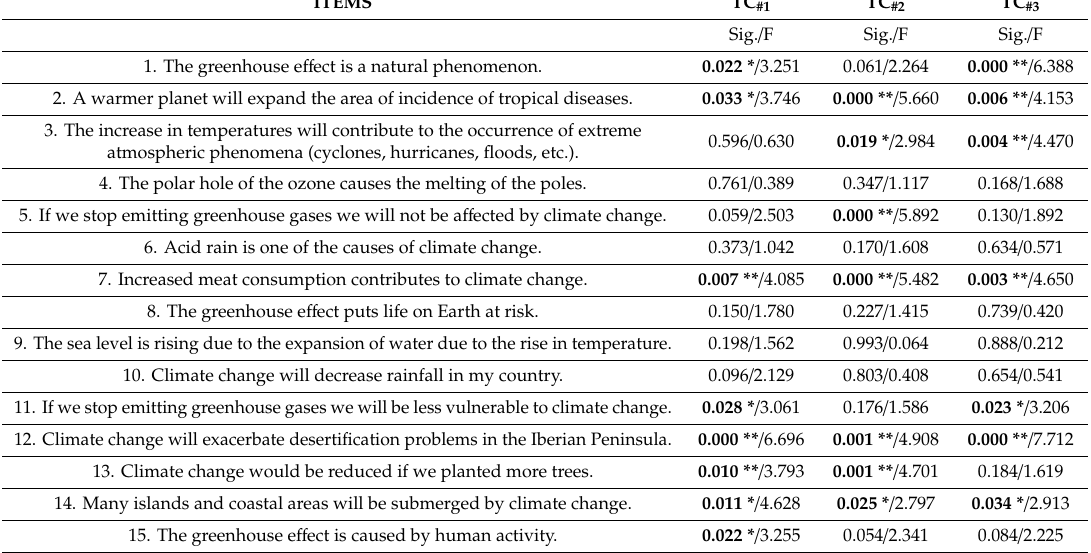
Table 10. To what extent do you feel informed about CC in general?